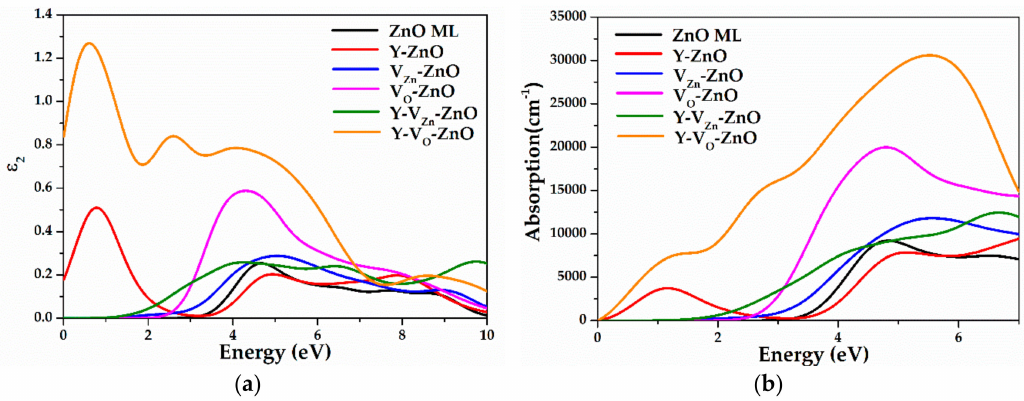
Figure 9. ( a ) The imaginary part of dielectric function and ( b ) the absorption coe ffi cient of ZnO ML, Y-ZnO, V Zn -ZnO, V O -ZnO, Y-V Zn -ZnO, and Y-V O -ZnO.